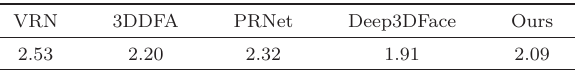
Table 5 Mean RMSE (in mm) for the MICC dataset, for various methods